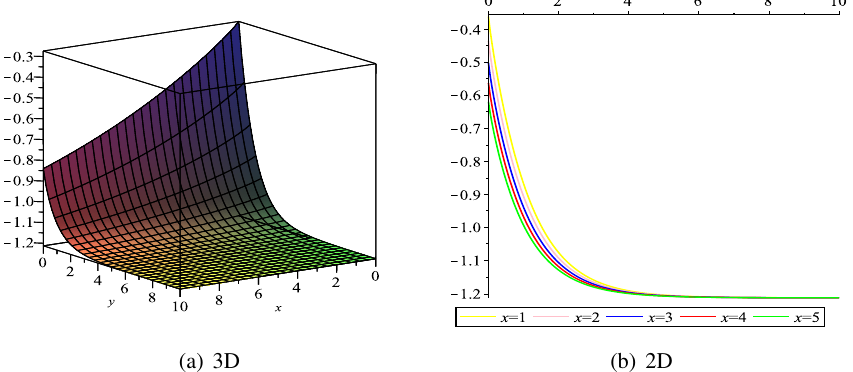
Fig. 2 The kink wave solution (44) for k 1 = 0 . 2 , k 2 = 1 . 5 , k 3 = 0 . 25 , c 2 = 0 . 5 , δ = − 1 . 2 , α = 0 . 9.